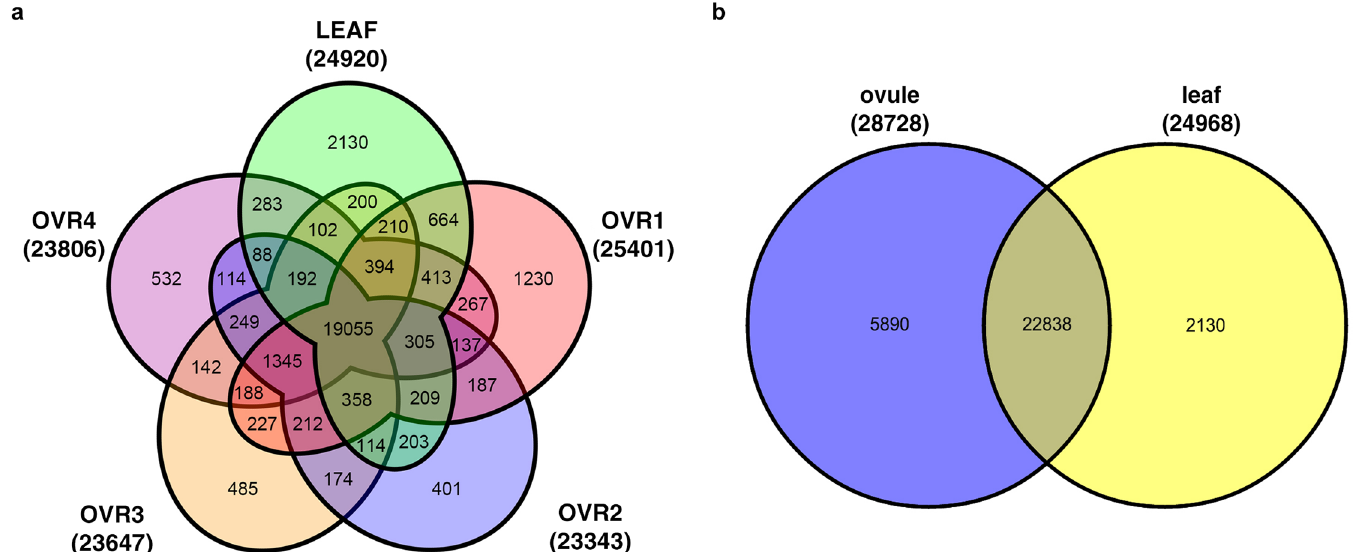
Fig 3. a Venn diagram showing the genes expressed in each of the four stages of rice ovule development and leaf. b Venn diagram showing the genes expressed between the union of four stages of ovule and the leaf.